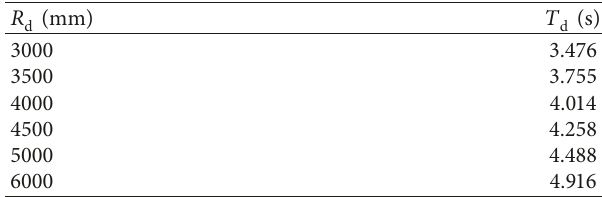
Table 3: The relationship between the periods of FPTMD and the radii of curvature of the FPB spherical surface.